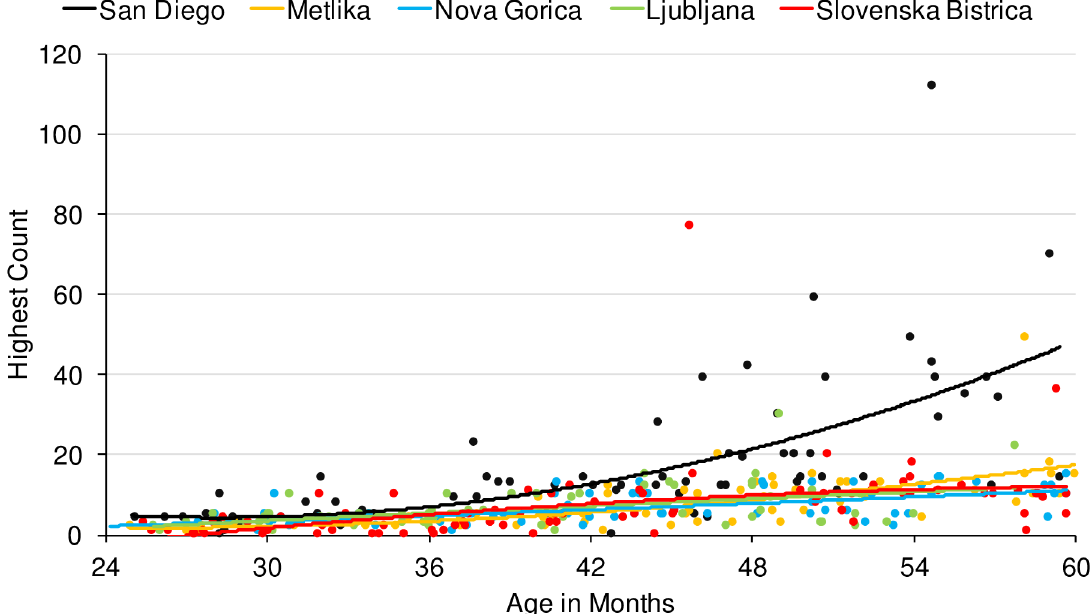
Fig 2. Highest count data for San Diego, Metlika, Nova Gorica, Ljubljana, and Slovenska Bistrica groups.